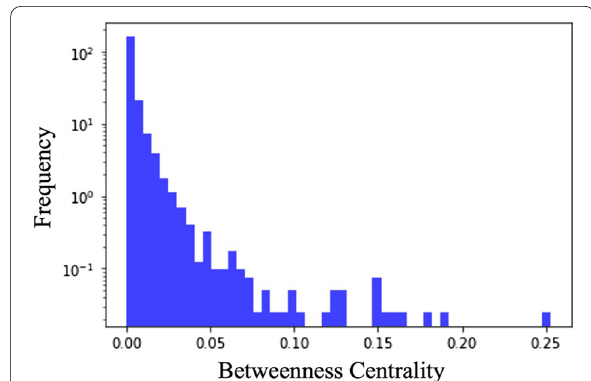
Fig. 7 Betweenness centrality distribution: In the graph, we can clearly see a few nodes with very high centrality. These are the nodes that represent the stations mentioned above